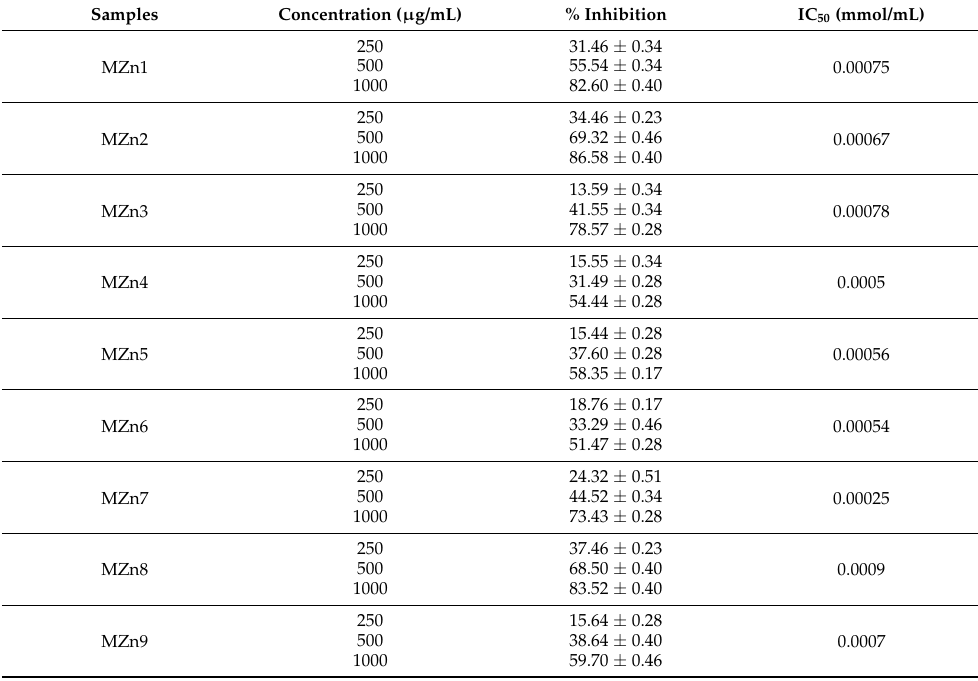
Table 9. α -Amylase activity results of